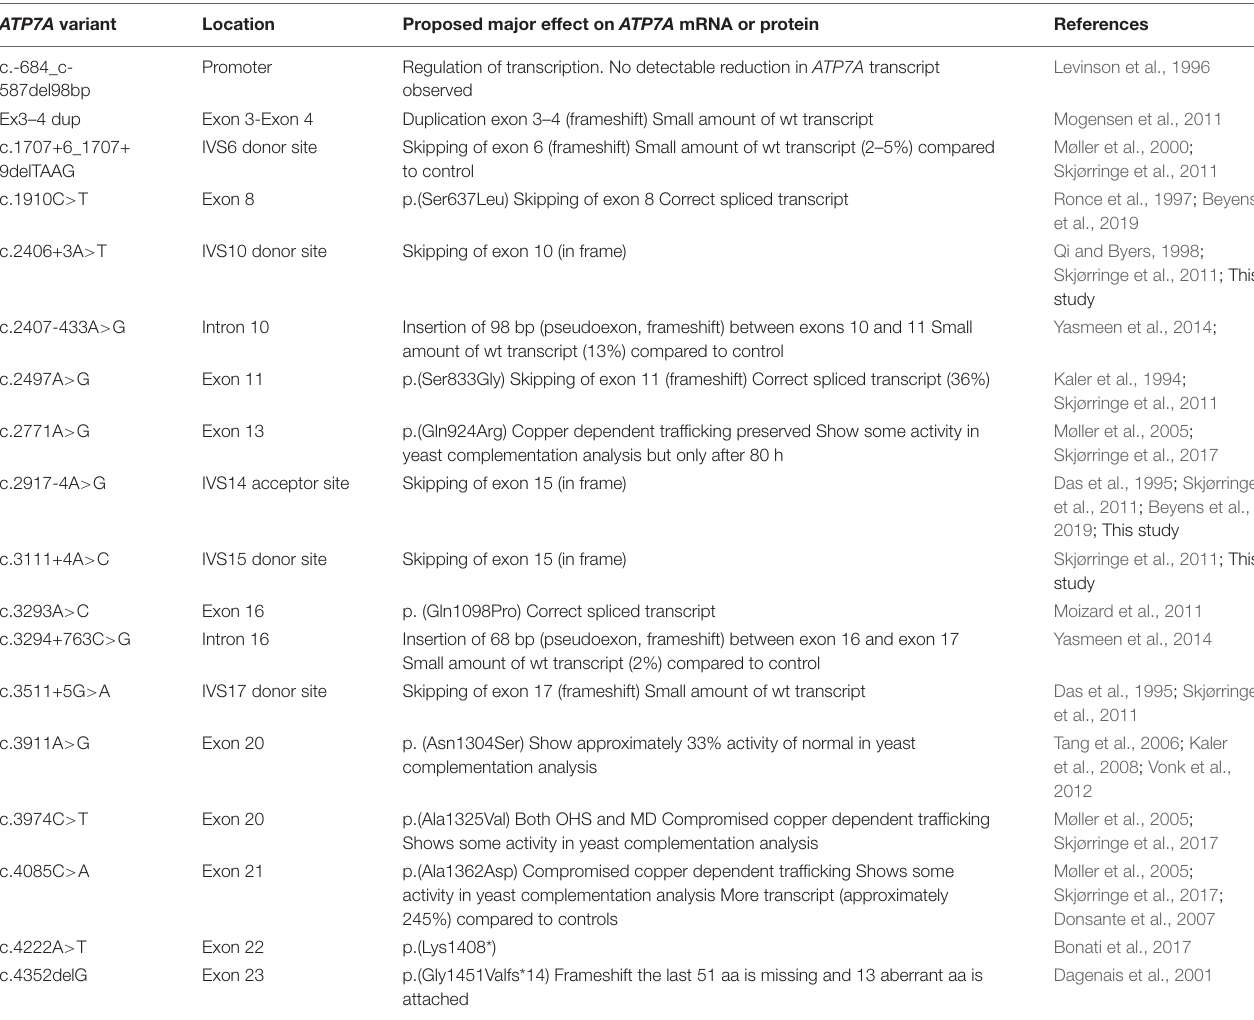
TABLE 1 | Published variants identified in individuals with OHS (18 different